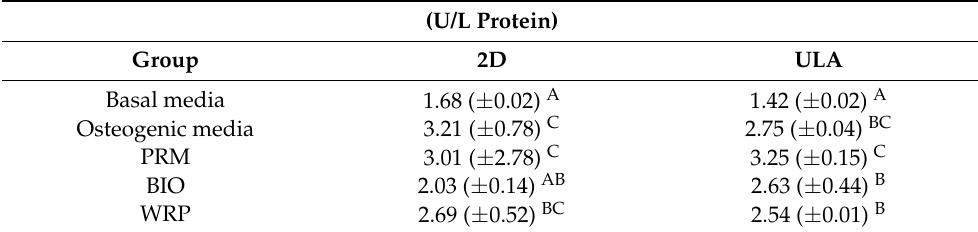
Table 4. Alkaline phosphate activity in the experimental groups.